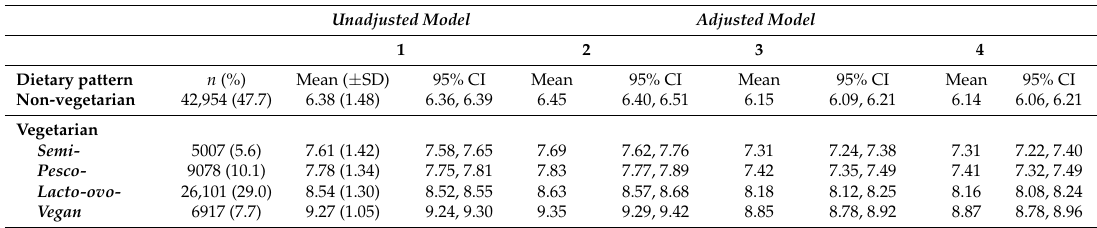
Table 3. Mean Vegetarian Lifestyle Index (VLI) score according to dietary patterns in the Adventist Health Study-2 (AHS-2) cohort. Dietary pattern Vegetarian